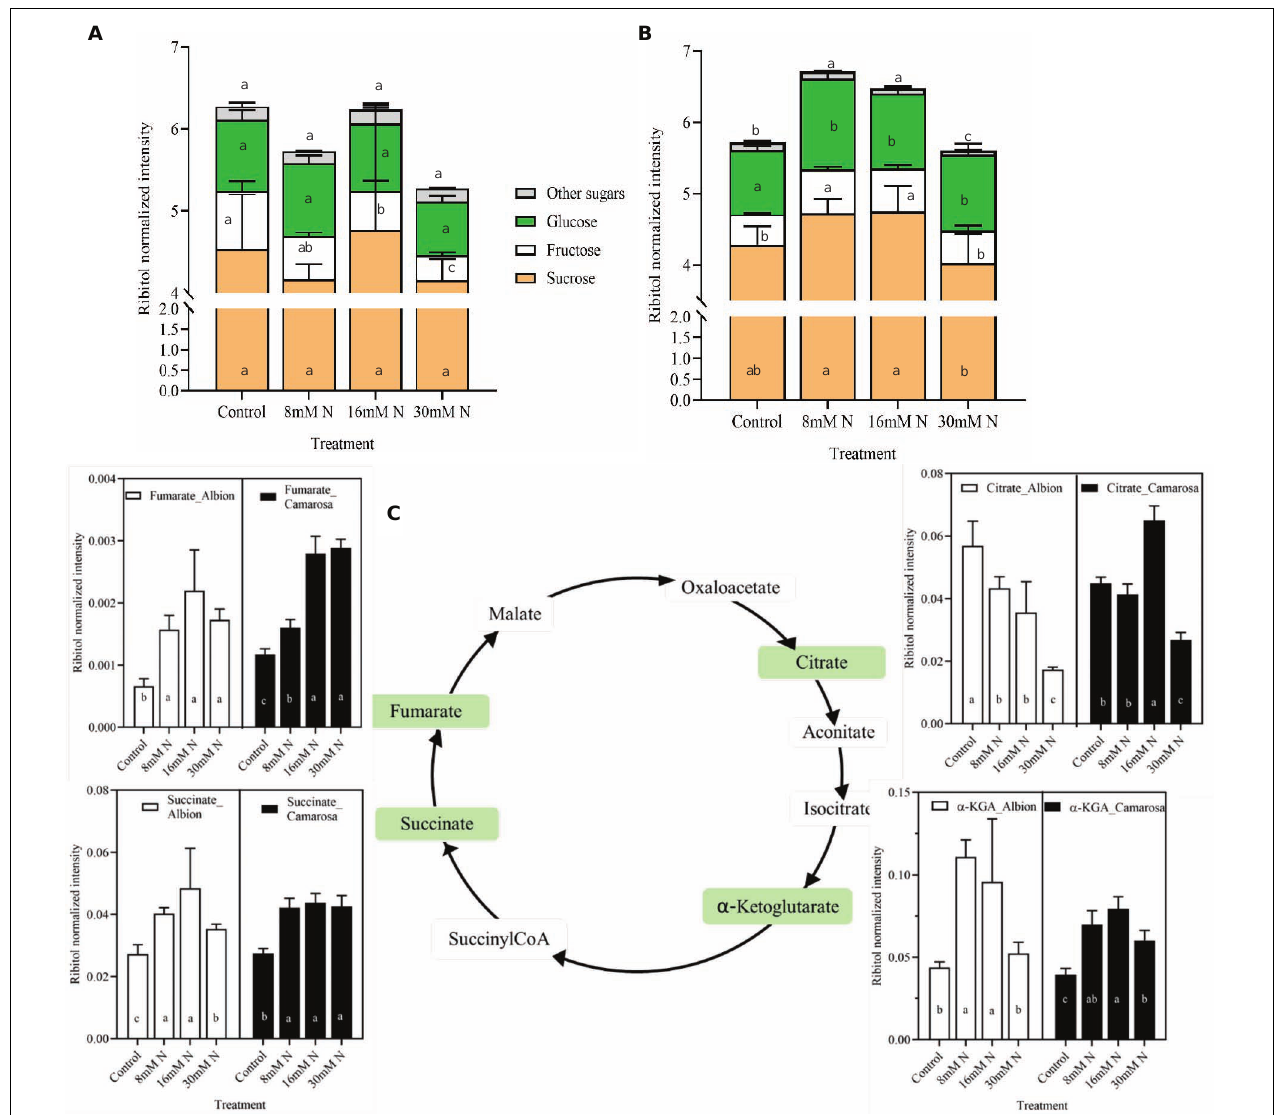
FIGURE 3 | Abundance of sugars in cv. Albion (A) and cv. Camarosa (B) and intermediaries of tricarboxylic acid (TCA) cycle (C) of cv. Albion (open bars) and cv. Camarosa (closed bars), as influenced by the four levels of N treatments. The data represent the mean ± SD ( n = 5) ribitol normalized abundance of the respective samples and were tested by one-way ANOVA with Tukey’s honestly significant difference (HSD). Bars with the same letters are not significantly different at the 95% confidence